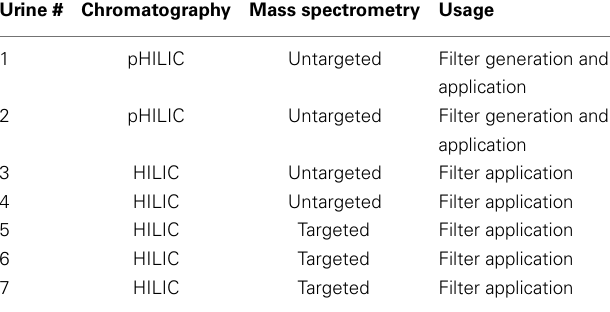
Table 1 | Schematic experimental design of human urines used in this study